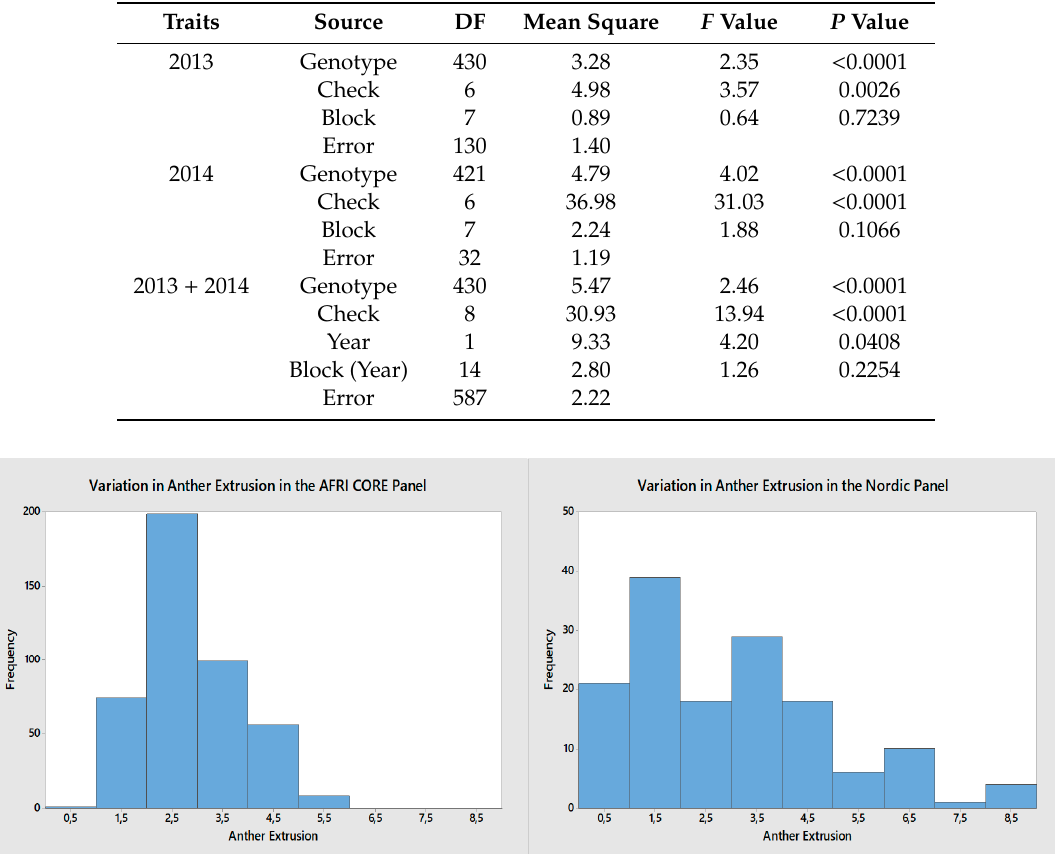
Table 1. Analysis of variance of anther extrusion in the AFRI CORE population.